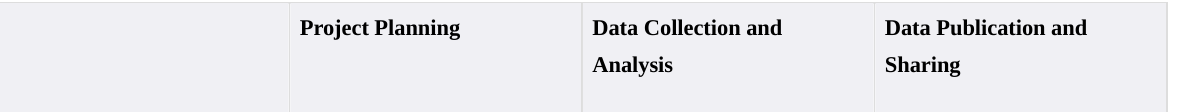
Table 1. Activities related to data management, reproducibility, and open science at different stages of a research